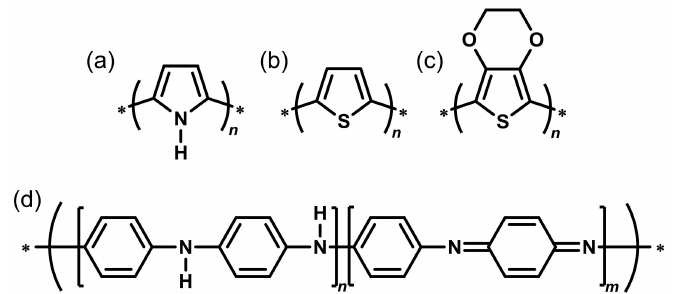
Figure 3. Commonly used conducting